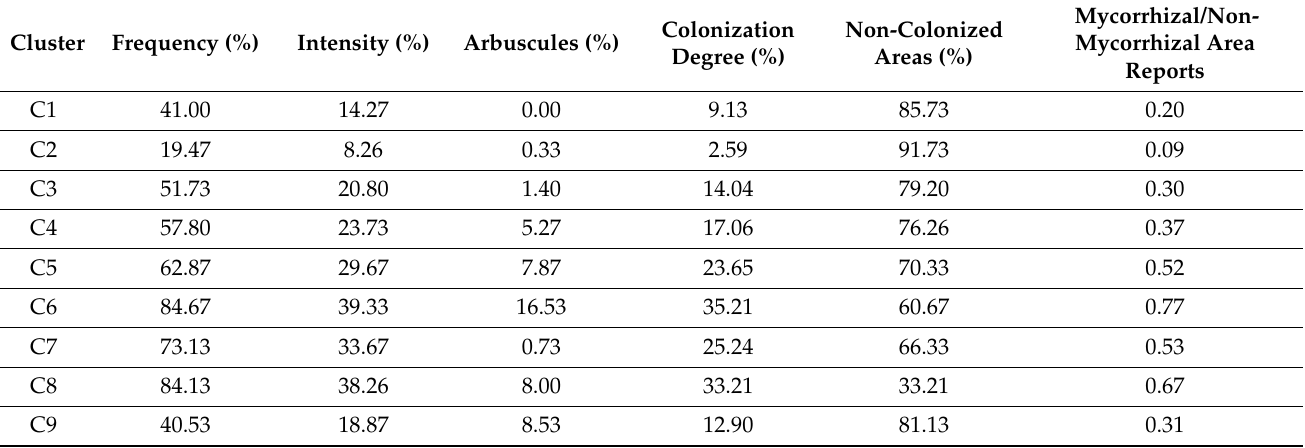
Table 2. Cluster groups defined by assemblage of mycorrhizal strategy based on colonization